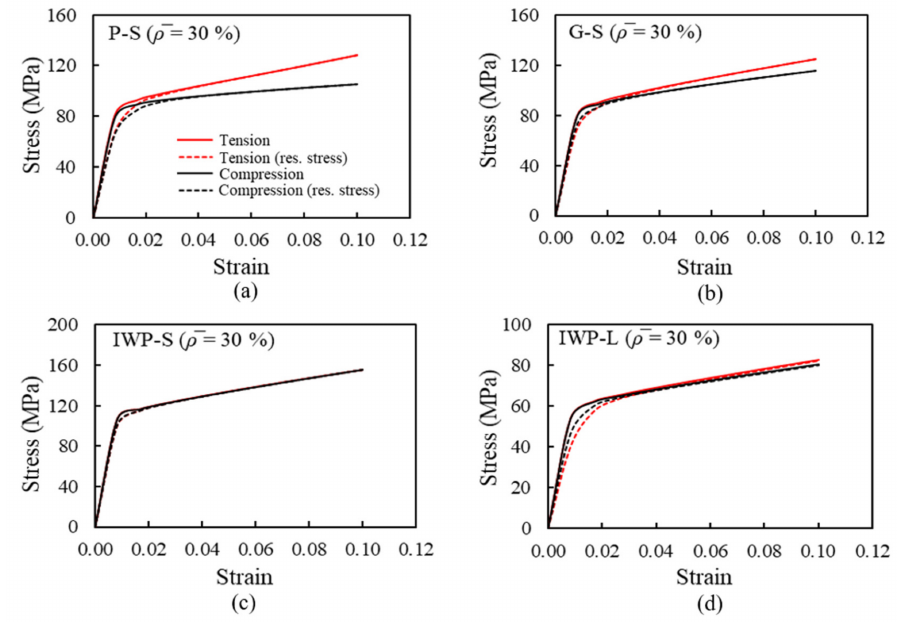
Figure 13. The stress–strain curve for tension/compression loading for ρ = 30% with and without residual stress: ( a ) P-S, ( b ) G-S, ( c ) IWP-S, and ( d )